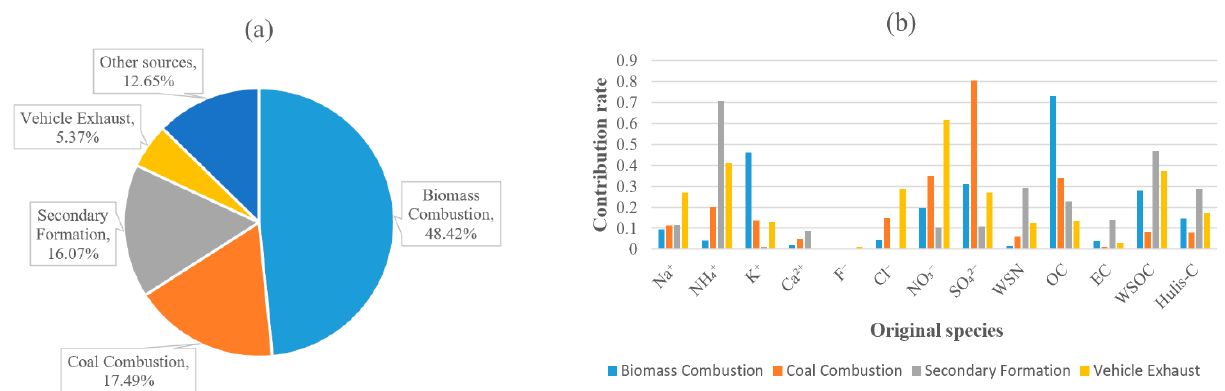
Figure 7. Source identification and apportionment by PCA: the proportion of the four possible key sources ( a ) and the concentration rate of different species to each source ( b ) .